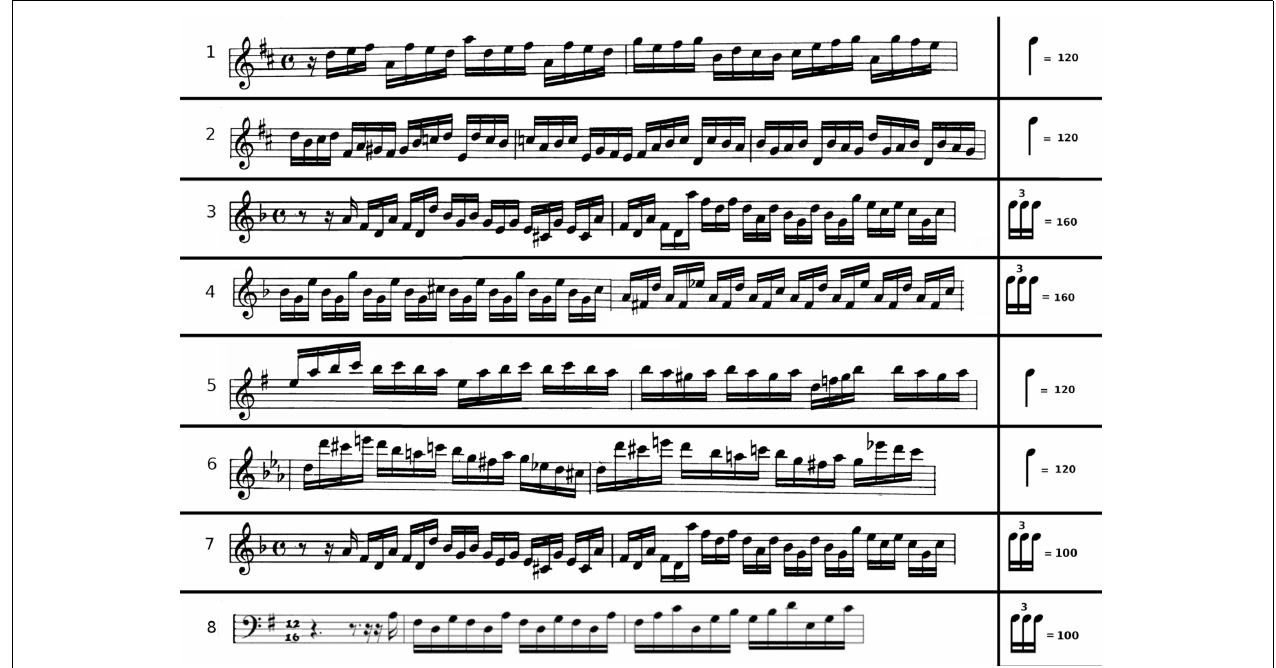
FIGURE 1 | Examples of musical stimuli. The first bars of the six musical sequences for study 1 are illustrated. Pieces 1 and 2 were adapted from the Prelude V of the Well-Tempered Clavier (Part 1) of Bach, pieces 3 and 4 were adapted from the Prelude VI and piece 5 from the Prelude X . The